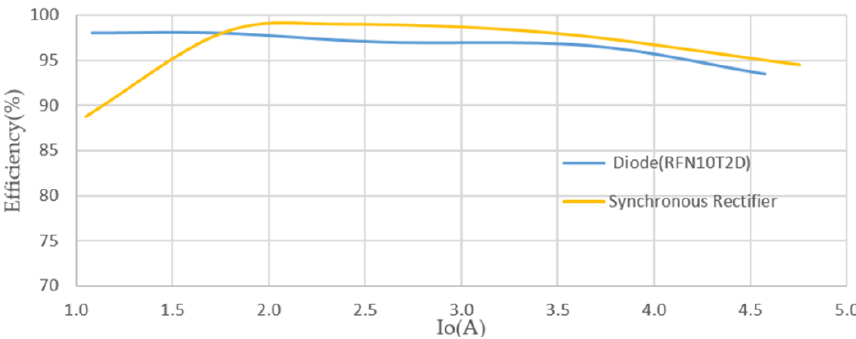
Figure 15. Rectification efficiency comparison.